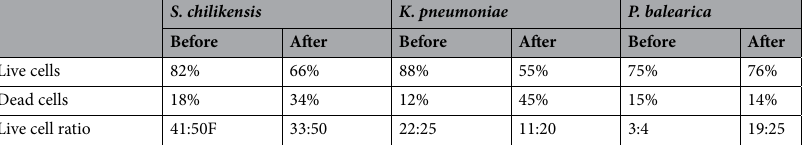
Table 2. Live and dead cell fluorescence intensity with live and dead cell ratio for oxidised surfaces before and after application of